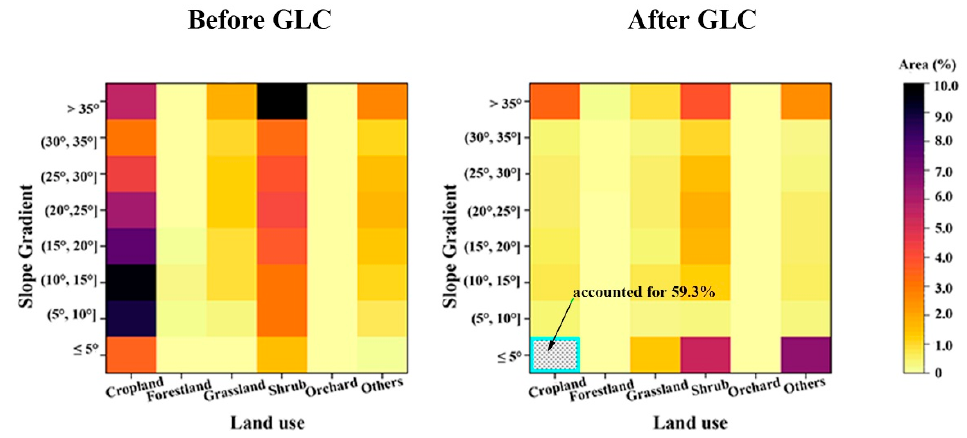
Figure 11. Land use and slope gradients in GLC area before and after the implementation of GLC. Note: Since the area of cropland with a slope gradient under 5 ◦ accounted for 59.3% after GLC, which is much higher than any other land use types, it was marked by a blue